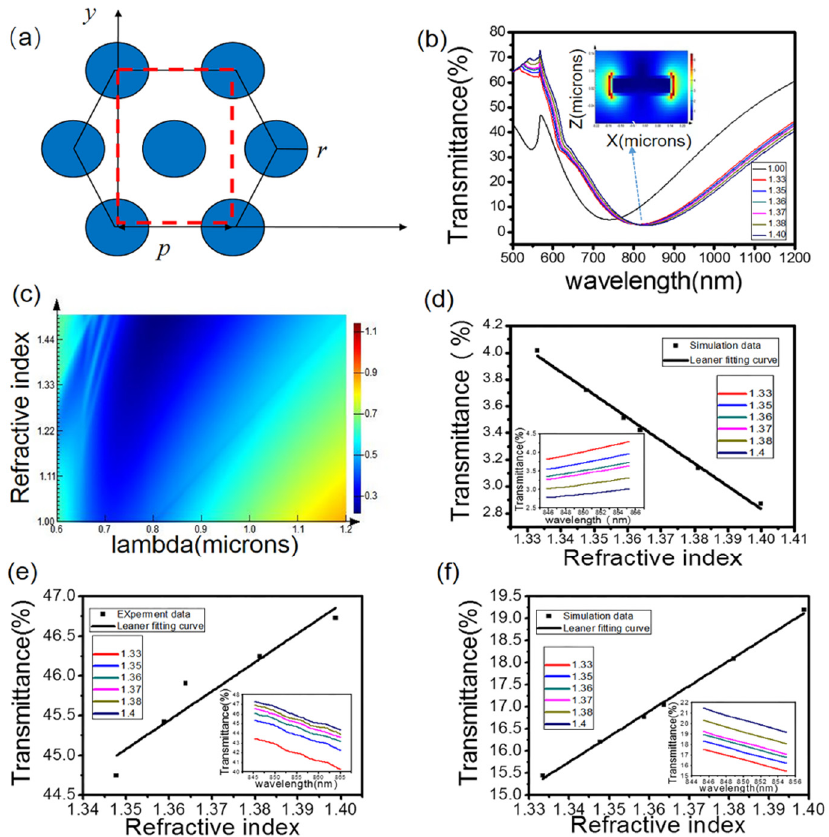
Figure 2. ( a ) Schematic diagram of a hexagonal array structure of single-crystal cell cycle. ( b ) Electric field distribution of cavity mode. ( c ) Variation of refractive index with a field strength of wavelength. ( d ) For the designed gold nanoparticle size, FDTD transmittance simulation sensitivity fitting results. ( e ) Test results of quartz glass transmittance. ( f ) For the actual gold nanoparticle size, FDTD transmittance simulation, and sensitivity fitting results.